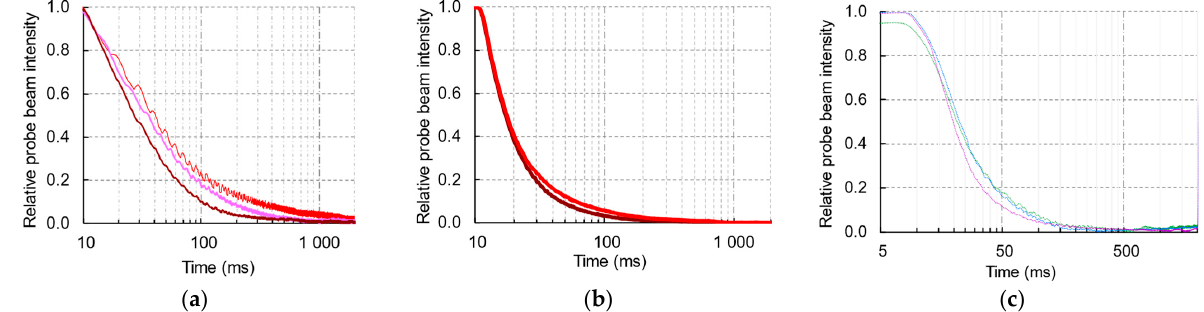
Figure 8. Normalized averaged transient thermal-lens curves for the heating stage: ( a ) ferroin (red line), myoglobin (light magenta line), and hemoglobin cyanide (dark red line) with the same absorbance: medium, TLS-60; excitation wavelength, 532.0 nm; excitation power, 47.5 mW. ( b ) Ferroin (red line) and hemoglobin cyanide (dark red line) with the same absorbance in 3 M NaCl; setup, TLS-60; excitation wavelength, 514.5 nm; excitation power, 40 mW. ( c ) Albumin solutions of various concentrations (no albumin, green; 20 g/L, blue; and 50 g/L, magenta) with the addition of ferroin (10 µM in a solution of 0.9% NaCl); for clarity, the X-axis is shown in the logarithmic scale. Setup, TLS-60; excitation wavelength, 514.5 nm; excitation power, 40 mW. The delay of the formation start is caused by opening the mechanical shutter.